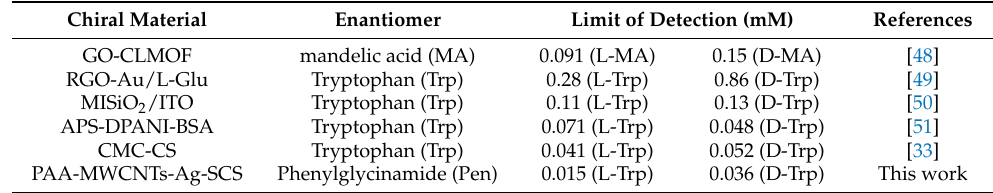
(Figure 11B): Ip ( µ A) = 1.17x + 103.61 (R 2 = 0.9997). This suggests that PAA-MWCNTs-Ag- SCS/GCE can be used to detect the percentage composition of one enantiomer (D-Trp%) in the enantio-enriched